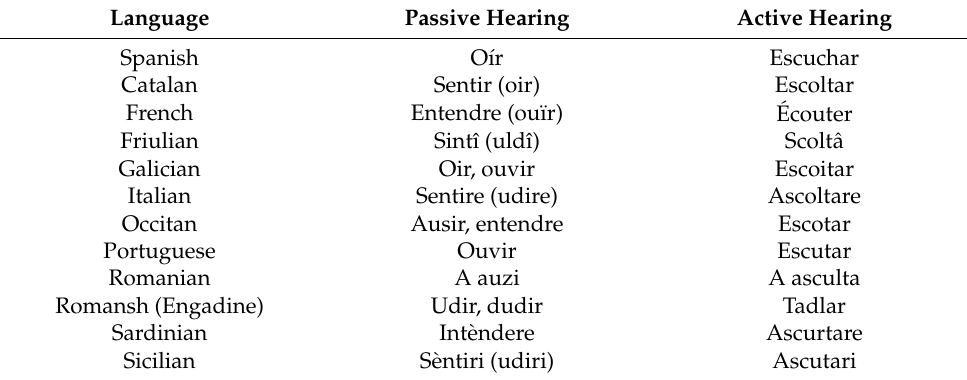
Table 1. Auditory perception verbs in Romance